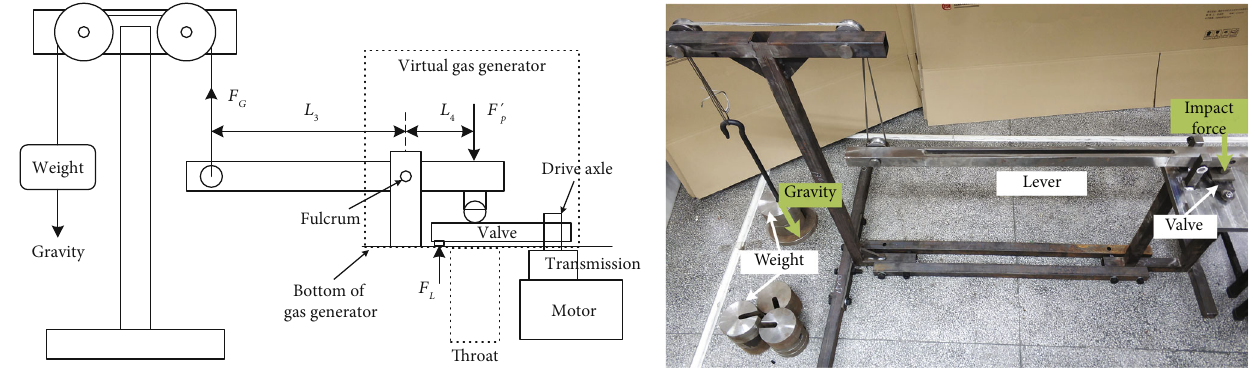
Figure 10: Working load simulation device for a gas generator.